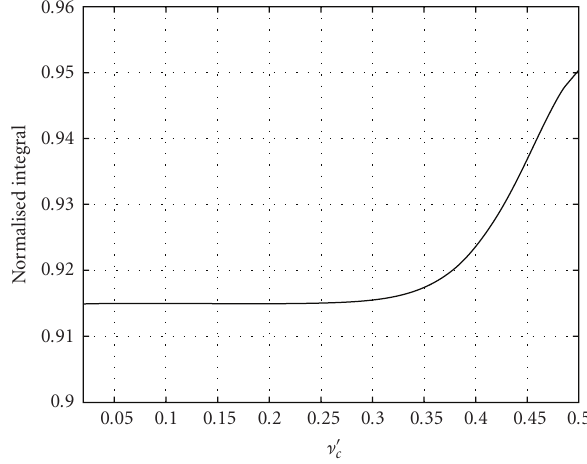
(cid:15) | (cid:8) η 9 ( ν (cid:2) ) | 2 d ν (cid:2) normalized to 2 ν (cid:2) λ